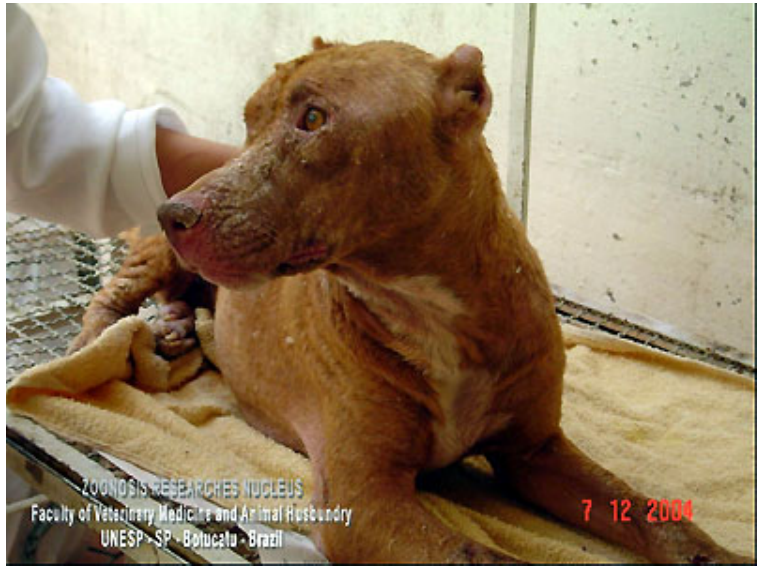
Figure 1: Clinical presentation of the dog, with generalized skin lesions in the body and partial damage of the external ears.